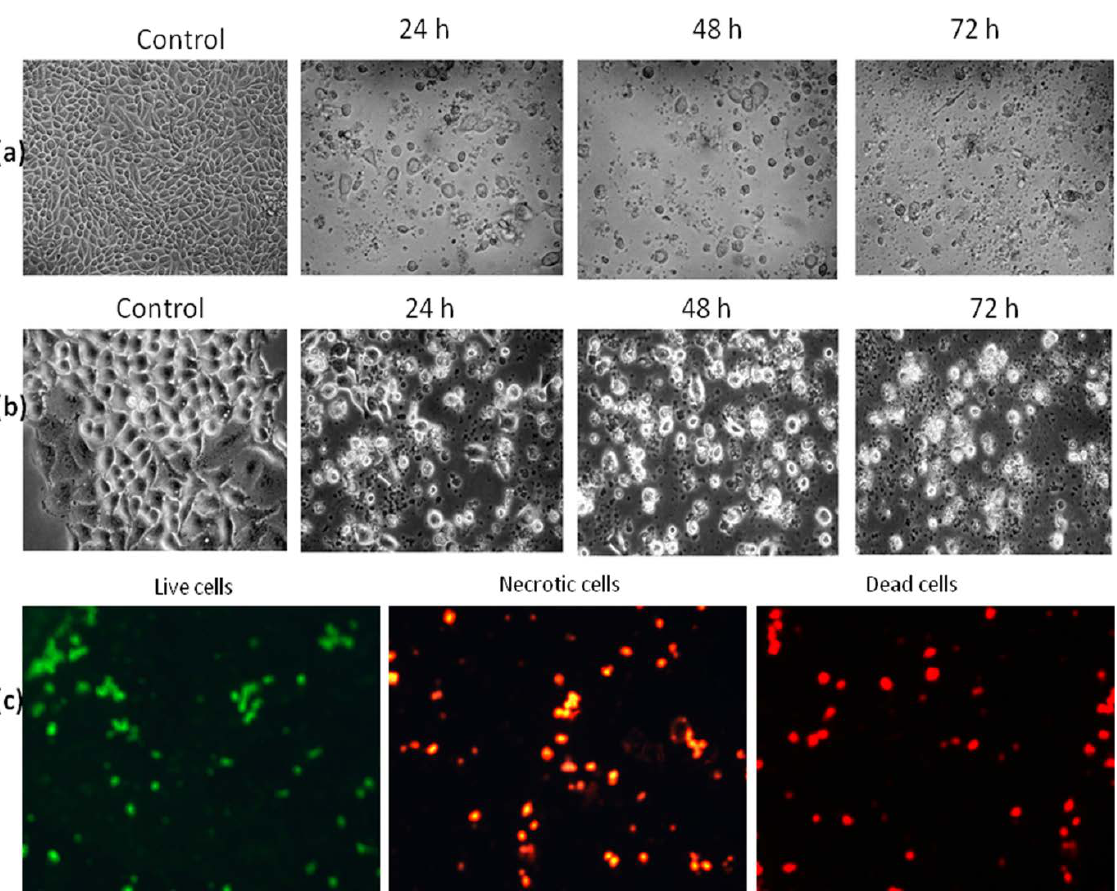
Figure 4. ( a ) Treatment with DMHE (38, 17 and 25 µg/mL) for 24, 48 and 72 h induces morphological changes in HT-29 colon cancer cells. Control or treated HT-29 cells as observed under inverted microscope and photographed; ( b ) control or treated HT-29 cells as observed under phase contrast microscope and photographed; and ( c ) treatment with DMHE for 48 h induces morphological changes in HT-29 colon cancer cells.